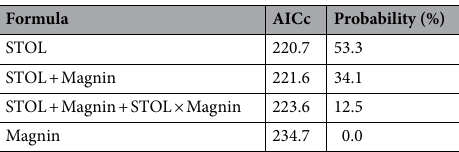
Table 4. Comparison of probability of STOL and Magnin models vs. successful trial of